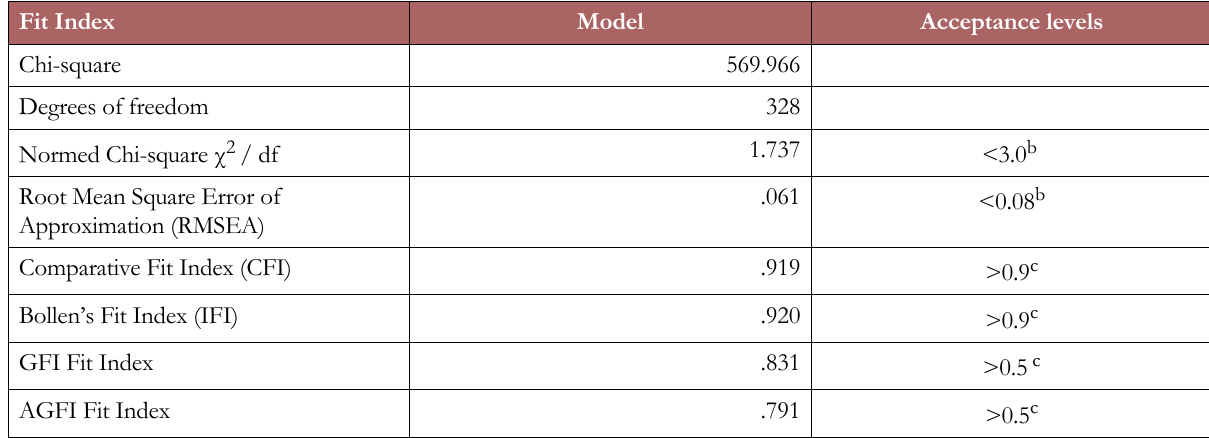
Table 6. Structural Equation